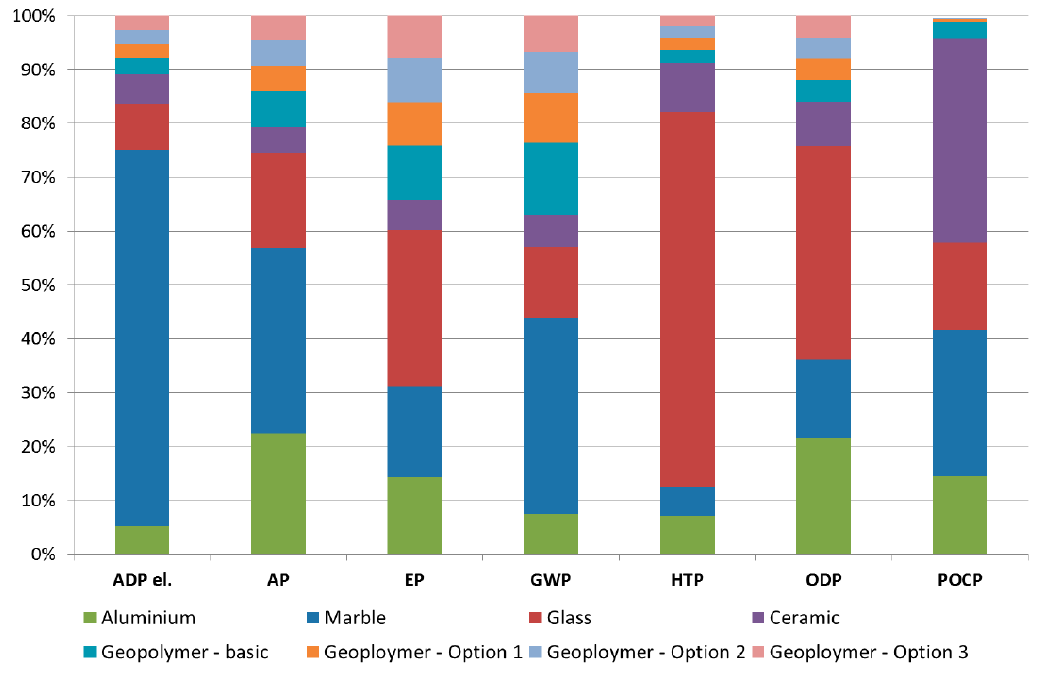
Figure 7. The comparison of the environmental performance of different façade cladding materials (the figure was produced by the authors).